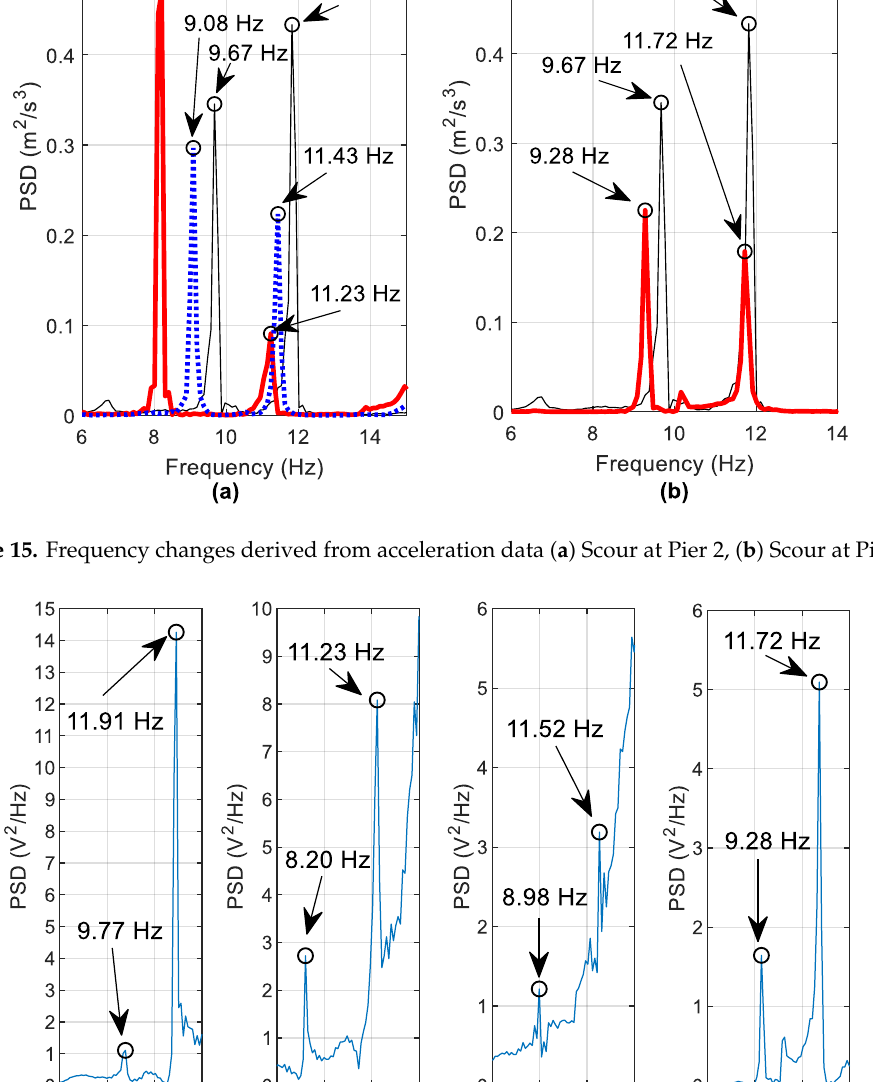
Figure 16. Frequencies observed from PSD of harvester voltage ( a ) Healthy case ( b ) 44.9% scour at pier 2 ( c ) 24.5% scour at pier 2 ( d ) 24.5% scour at pier 3.